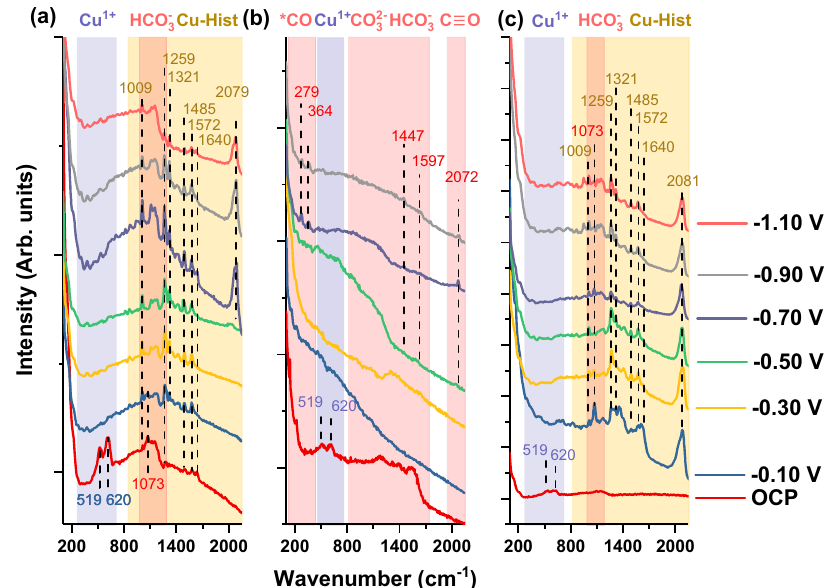
Fig. 3 | In-situ Raman spectroscopy on bare and histidine functionalised Cu 2 O under CO 2 RR relevant conditions. Comparisons were made on three different conditions to ascertain histidine presence during CO 2 RR and the expected *CO binding con fi guration on a electrodeposited Cu 2 O with added 0.025M histidine dissolved in the electrolyte. b Cu-0 and c Cu-Hist. Measurements were stopped at differentpotentialsdependingonthevigorousnessofthebubblingthatdisruptsin-